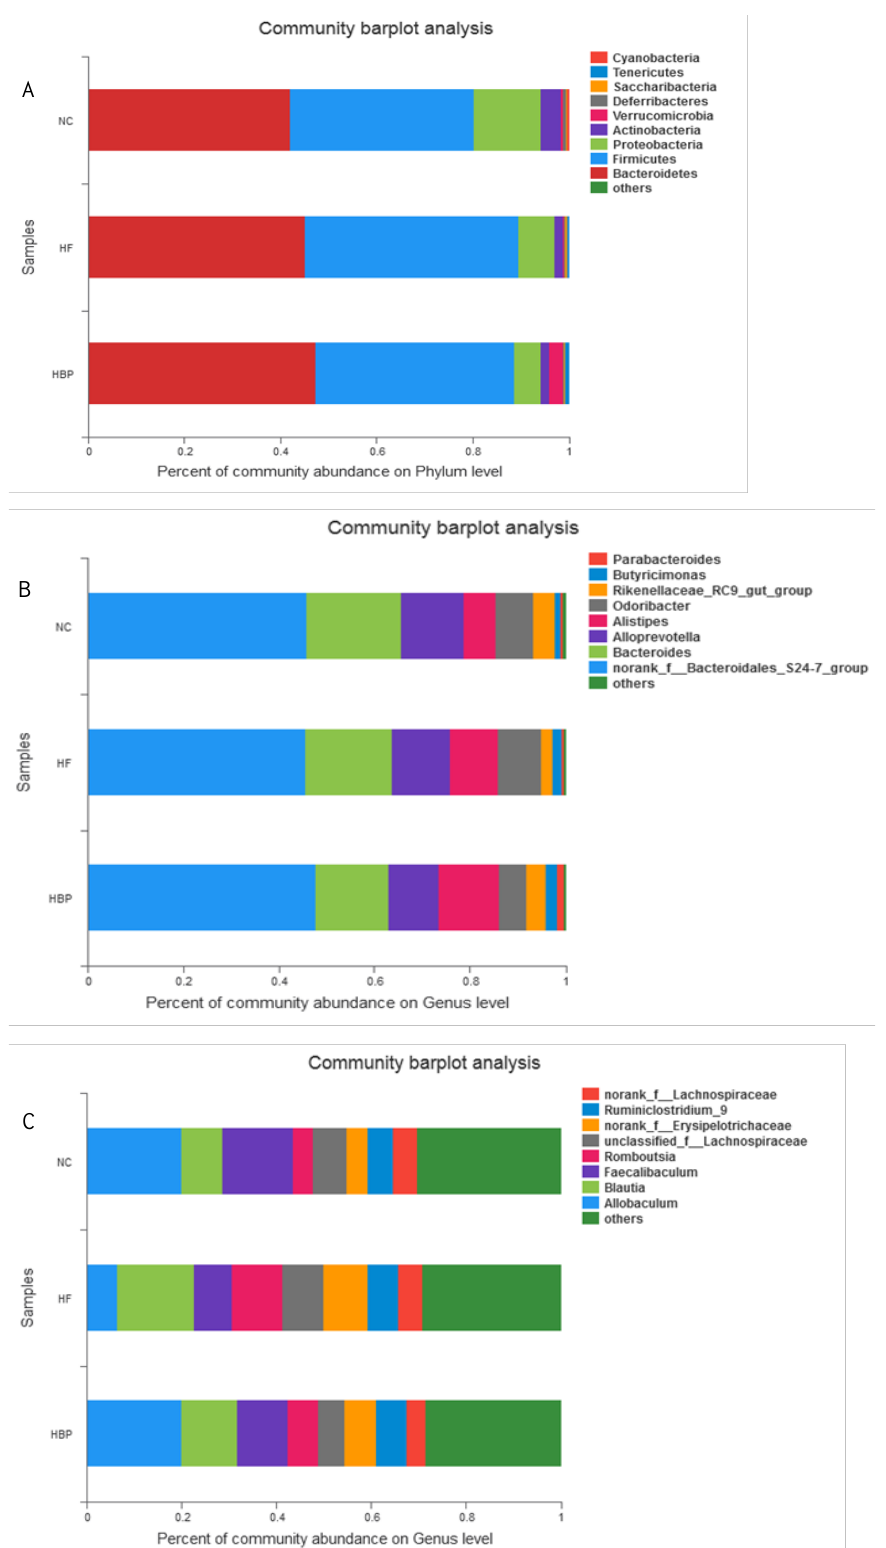
Figure 7. Effects of HBP on the relative abundance of bacteria at different levels in the feces of NC, HF, and HBP groups mice: ( A ) The differences of 9 main bacteria phyla of gut microbiota of mice; ( B ) the differences in the relative abundance of bacteria at genus level in the phylum Bacteroidetes ; ( C ) the differences in the relative abundance of bacteria at genus level in the phylum Firmicutes